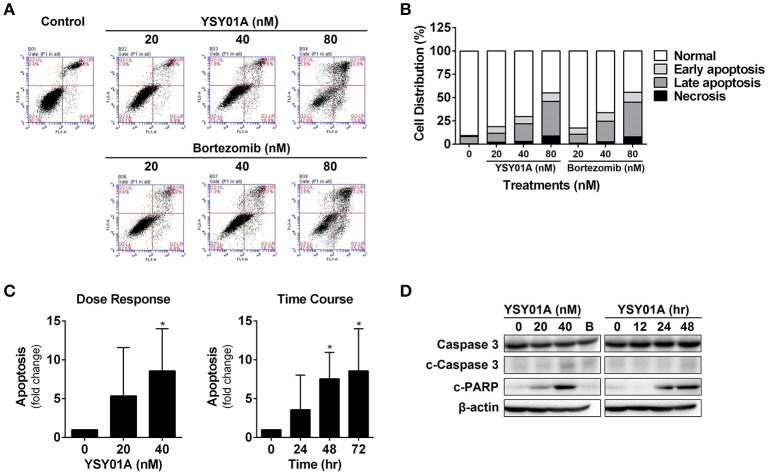
YSY01A induces apoptosis in A549 cells. (A) Following treatment with 0 (vehicle control), 20, 40 nM or 80 nM YSY01A or bortezomib for 48 h, A549 cells were subjected to Annexin V/PI staining and flow cytometry analysis to determine apoptotic cells. Shown is a representative of flow cytometry data. Viable cells (left bottom quadrant, Annexin V−/PI−), early apoptotic cells (right bottom quadrant, Annexin V+/PI−), late apoptotic cells (right upper quadrant, Annexin V+/PI+) and necrotic cells (left upper quadrant, Annexin V−/PI+). (B) Percentages of cells in each quadrant are shown. (C) YSY01A-induced apoptosis was determined using the Cell Death Detection ELISAPLUS Kit. (*p < 0.05, by Student's t-test as compared with vehicle control) (D) Immunoblotting with cleavage of caspase 3 and PARP. β-actin was used as a loading control. B, bortezomib.